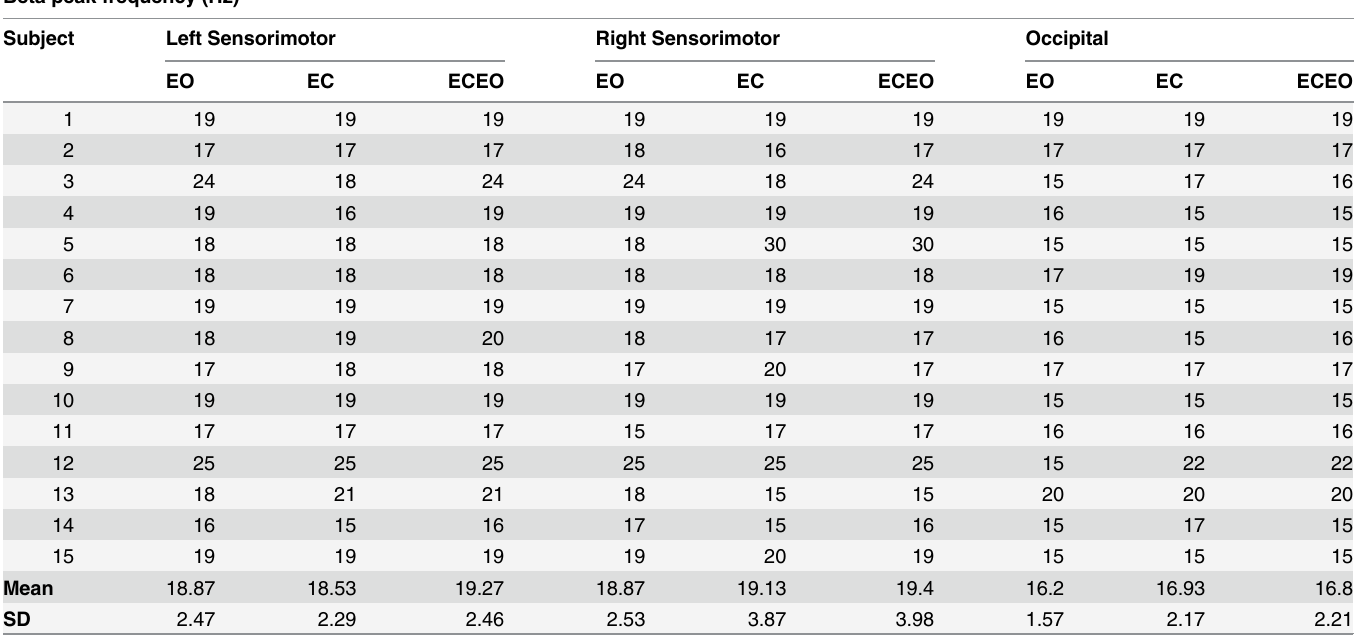
Table 2. Beta peak frequencies per MEG ROI and condition.